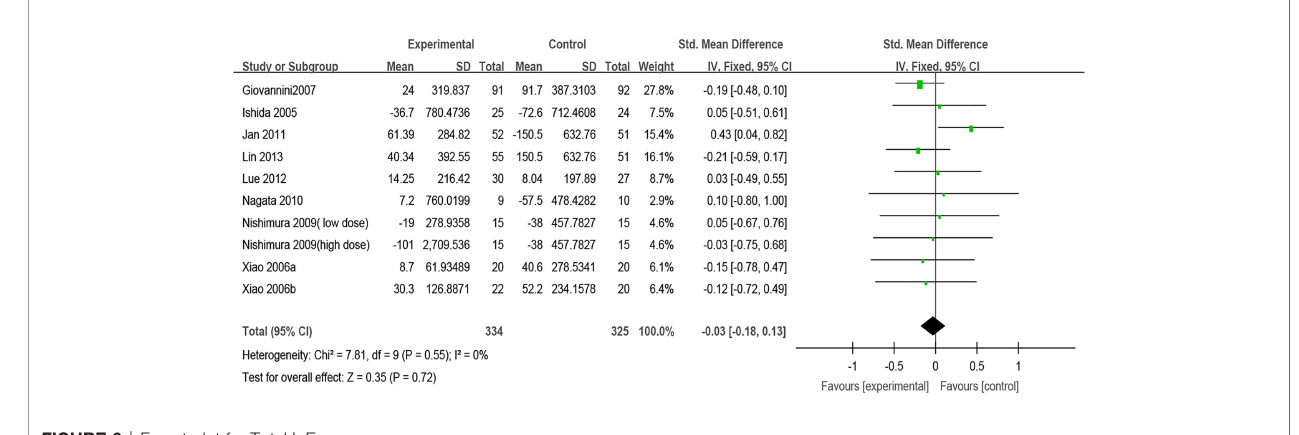
FIGURE 6 | Forest plot for Total IgE.